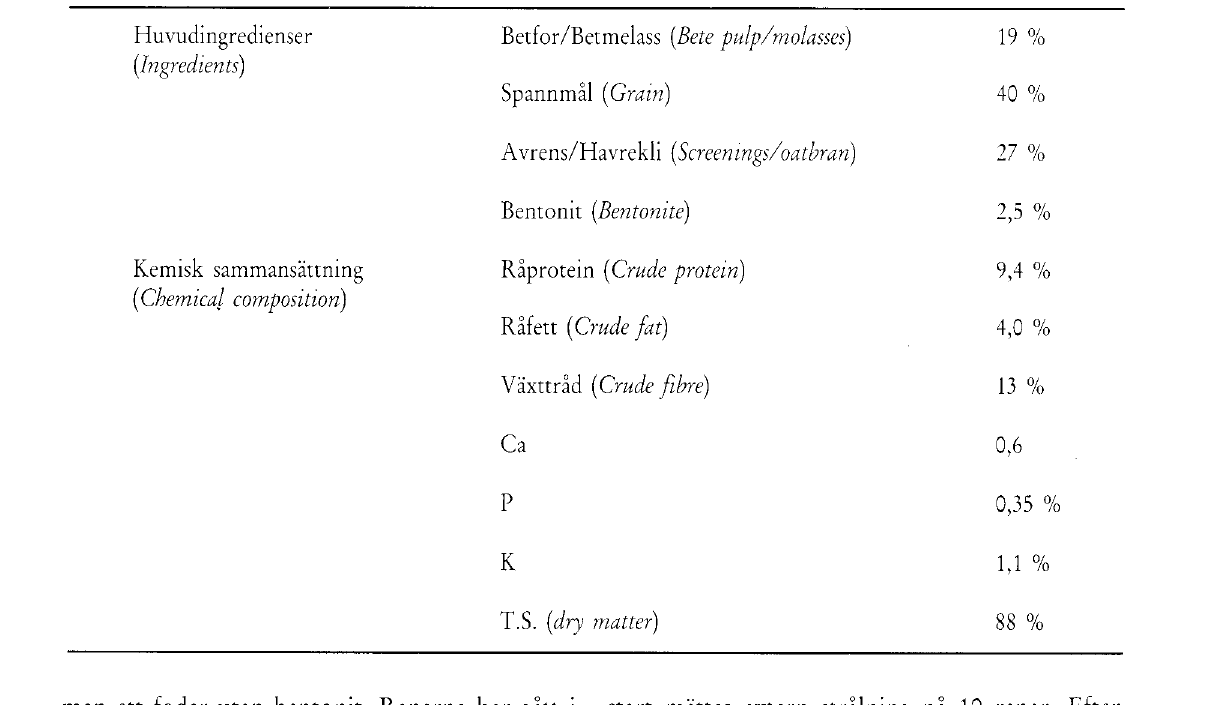
Table 2. Composition of pelleted reindeer feed used when feeding reindeer to lower their radiocaesium levels. Huvudingredienser Betfor/Betmelass [Bete pulp/molasses) 19 %